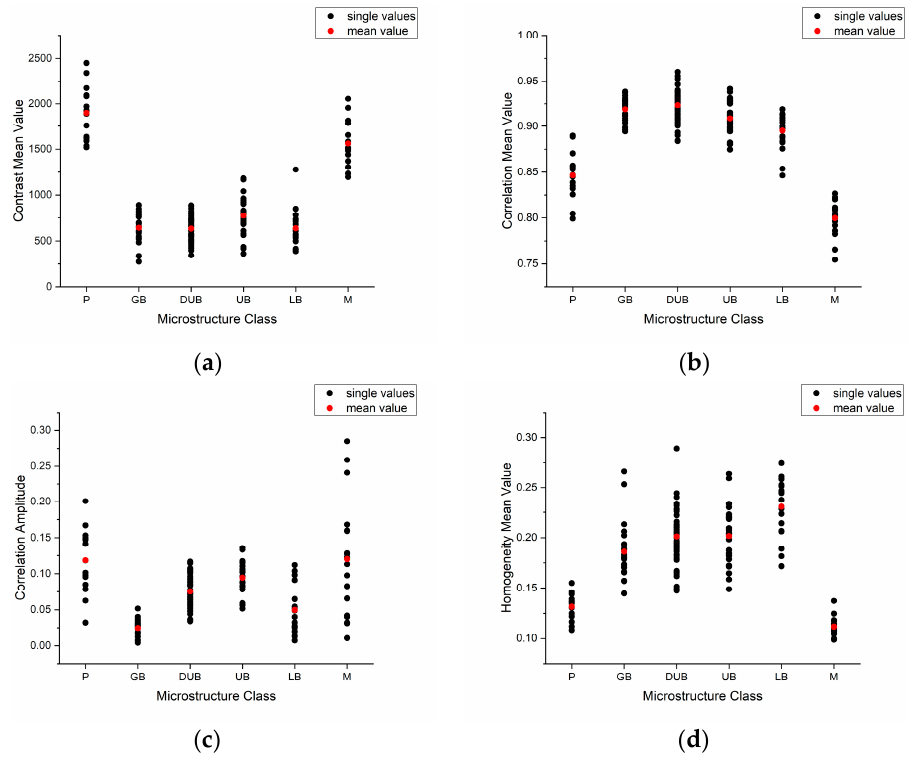
Figure 8. Haralick Parameters: ( a ) contrast mean value, ( b ) correlation mean value, ( c ) correlation amplitude, and ( d ) homogeneity mean value.